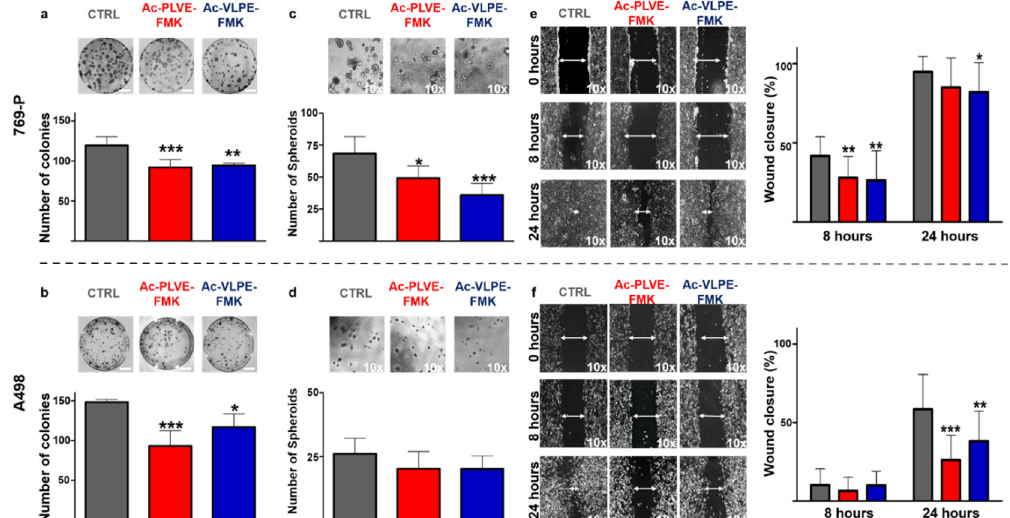
Figure 4. Effect of the peptides on renal cancer cell biology: colony formation assay of ( a ) 769-P and ( b ) A498 under treatment with Ac-PLVE-FMK and Ac-VLPE-FMKI. The cells were treated for 48 h with 20 µ M inhibitors and seeded into 10 culture dishes (10 cm diameter) at low confluency where they grew with or without the peptides for an additional 10 days. Representative images of the colony formation assay and quantitative data analysis are shown in the graph. ( c ) 769P and ( d ) A498 spheroid formation evaluated after 7 days of culture on Matrigel coated dishes. The graph is showing the number of spheroids. ( e ) 769-p and ( f ) A498 scratch assay. The graph shows the cell migration rate. All pictures were taken under 10 × magnification. Data are expressed as mean ( ± S.D.), and significance was calculated through one-way ANOVA followed by Dunnet’s test. * = p < 0.05, ** = p < 0.01, *** = p < 0.001.